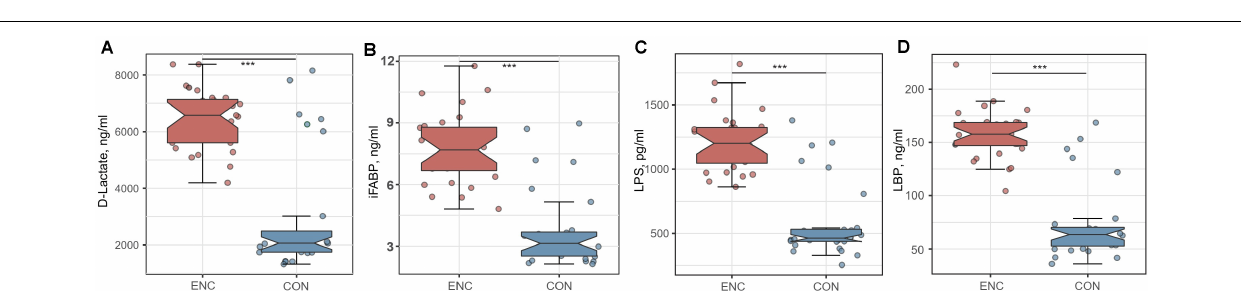
FIGURE 5 | Comparison of intestinal integrity biomarkers between encephalitis patients and healthy controls. (A) D-lactate; (B) iFABP; (C) LPS; (D) LBP. *** p < 0.001; Mann-Whitney U test. iFABP, intestinal fatty acid-binding protein; LPS, lipopolysaccharide; LBP, lipopolysaccharide-binding protein; ENC, patients with encephalitis; CON, healthy subjects serving as